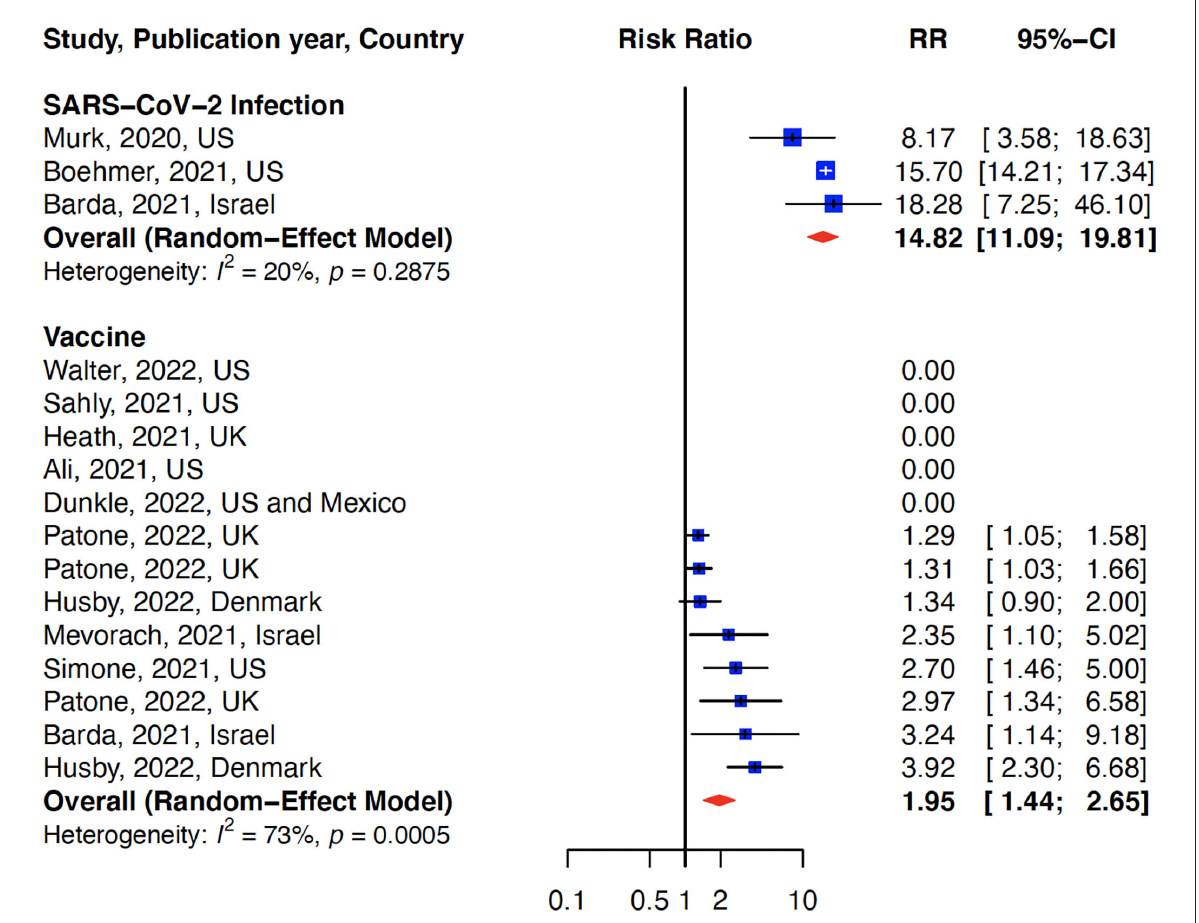
FIGURE2 Association of myocarditis after COVID-19 vaccination versus SARS-CoV-2 infection. The risk of myocarditis from infection was more than 7-fold higher than